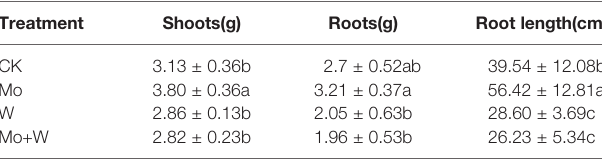
TABLE 1 | The shoots and roots dry weight and root length of strawberry seedlings. Treatment